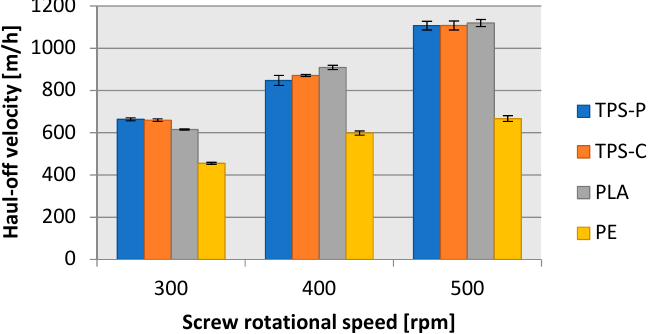
Figure 13. Dependence of the haul-off velocity of film collection on the rotational speed of the extruder screw.